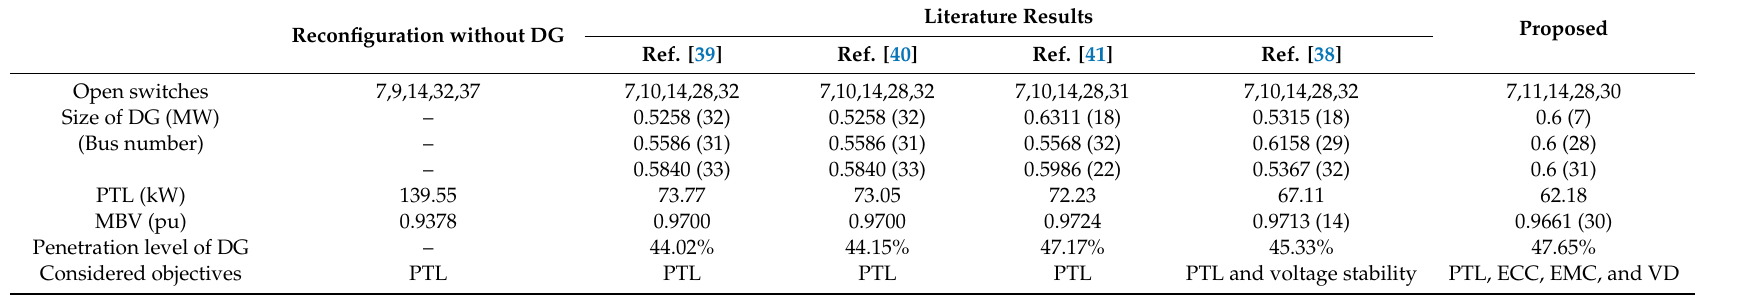
Table 14. Comparison of reconfiguration results under the deployment of 3